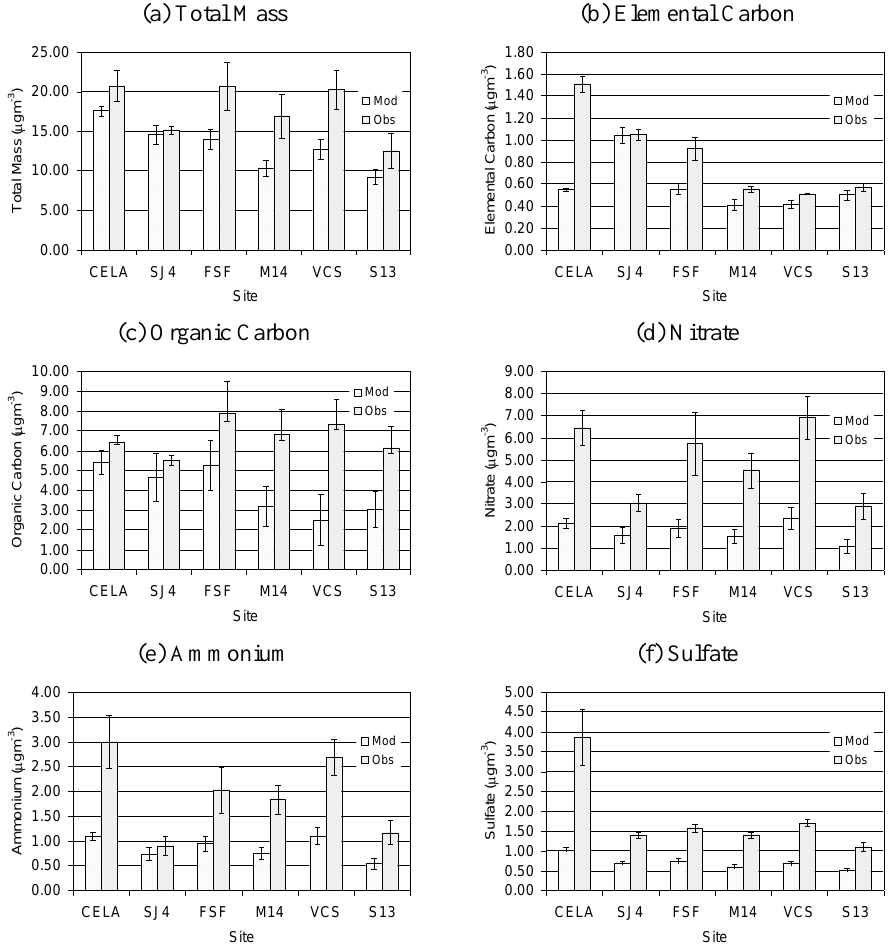
Fig. 4. Comparison between modeled and observed 7-year average PM 2 . 5 (a) total mass, (b) elemental carbon, (c) organic carbon, (d) nitrate, (e) ammonium, and (f) sulfate concentrations at different sites in California: (1) CELA-central Los Angeles North Main St, (2) SJ4-San Jose 4 th St, (3) FSF-Fresno 1 st St, (4) M14-Modesto 14 th St, (5) VCS- Visalia Church St, and (6) S13-Sacramento T St.